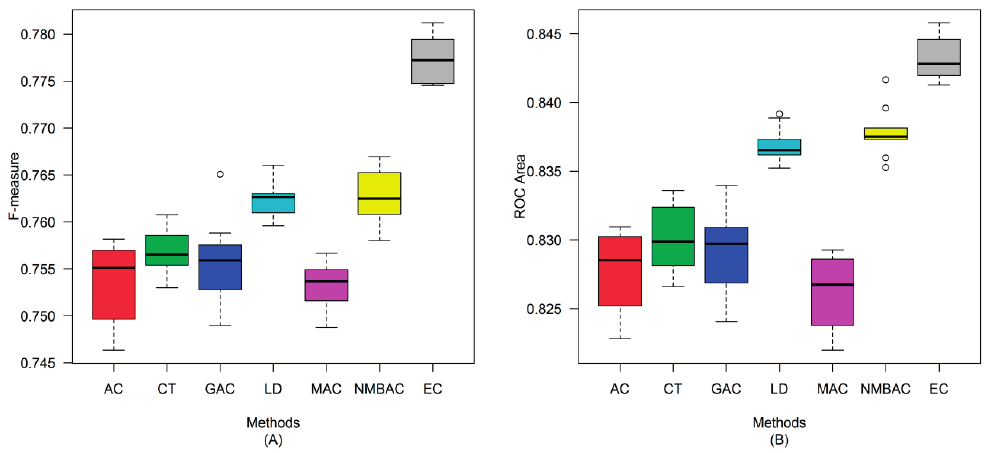
Figure 12. Average F-measure and ROC area of different methods on the Silver Yeast dataset with five-fold cross-validation. ( A ) F-measure; ( B ) ROC